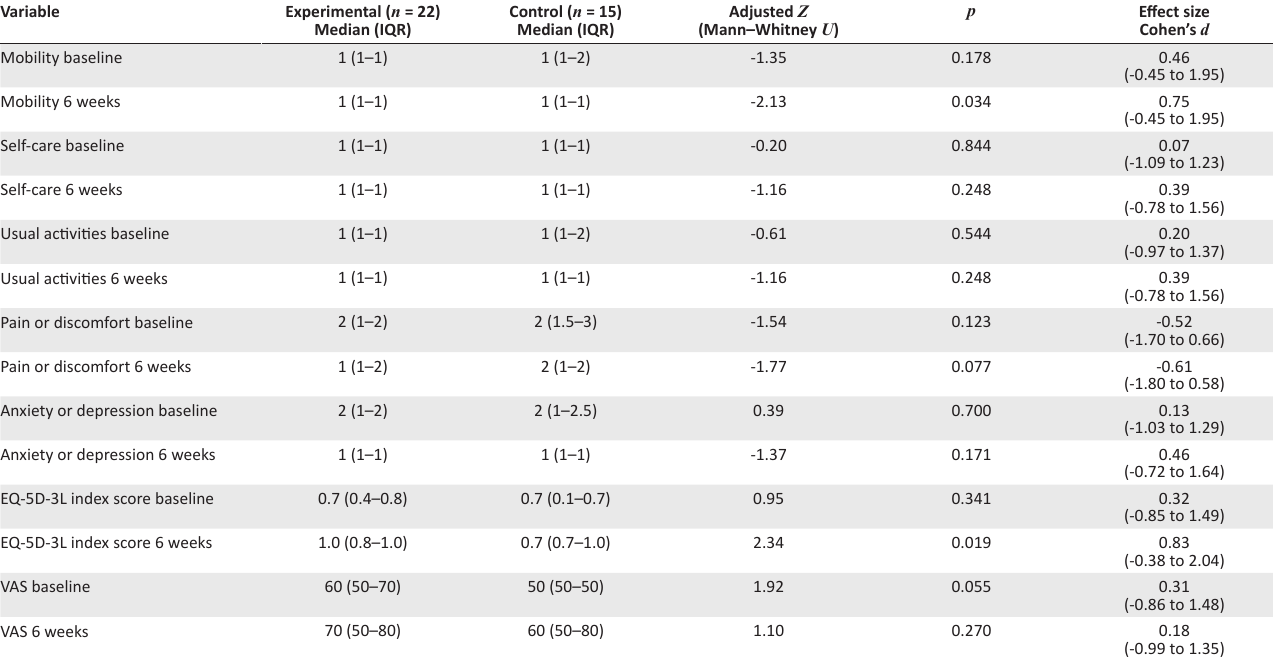
FIGURE 3: Baseline and 6 weeks frequency of responses to the five dimensions of the EQ-5D-3L for the control group. TABLE 3: Between-group comparison of rank ordering of health-related quality of life measures at baseline and at 6 weeks.